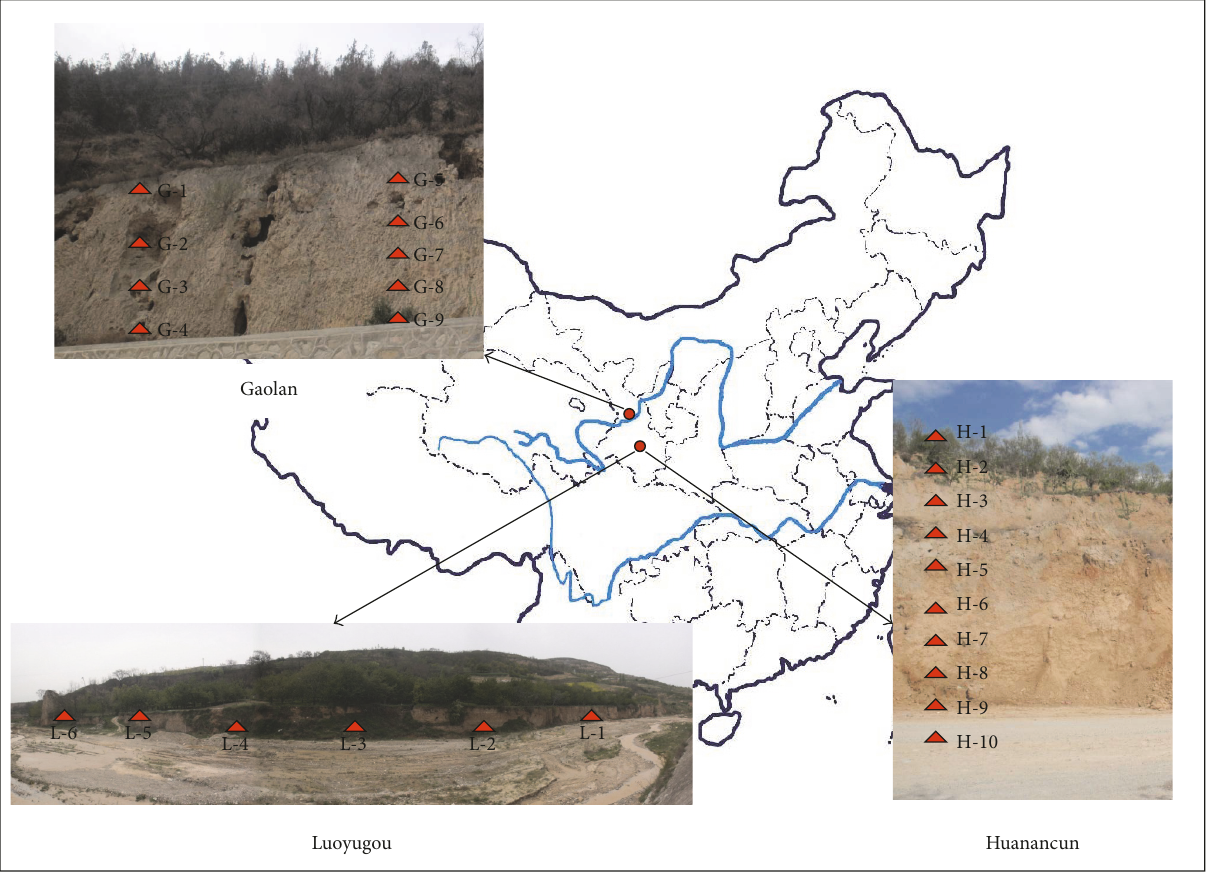
Figure 1: Location of